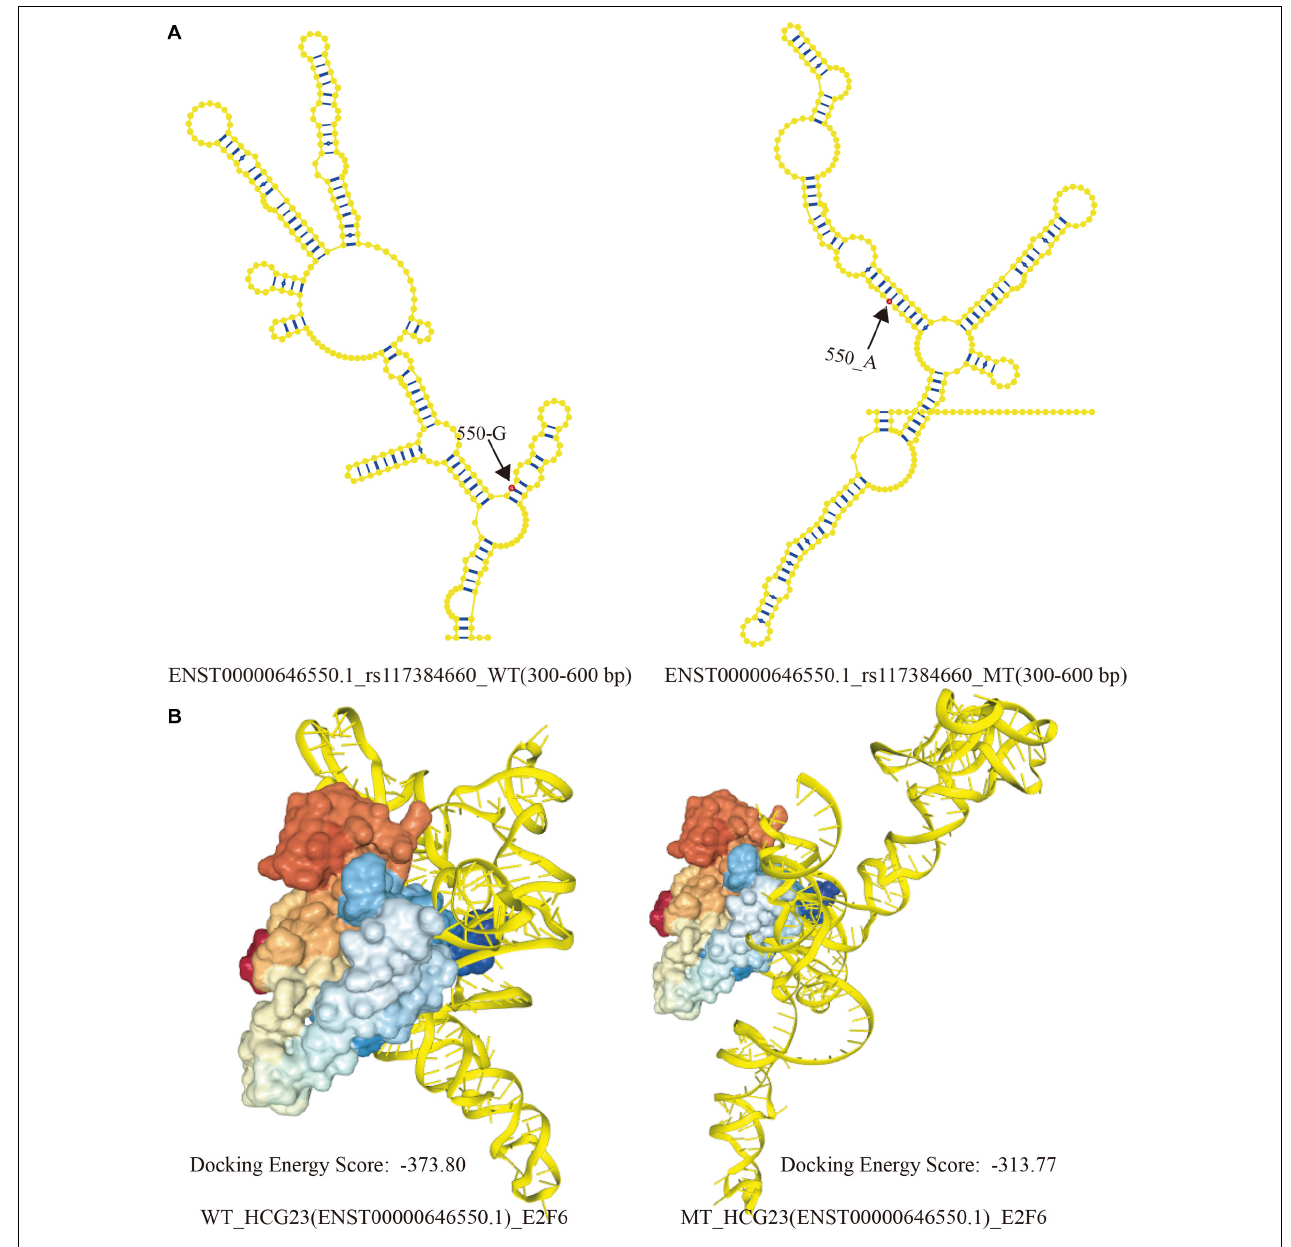
FIGURE 5 | Local structural visualization and prediction of molecular binding. (A) The local secondary structures of WT and MT HCG23 (ENST00000646550.1) induced by rs117384660. Bases in red showed the SNP sites in lncRNA transcript, and the numbers indicated location of SNPs. (B) Predictions of the structural conformations in interactive regions between WT and MT HCG23 and E2F6 induced by LD SNPs using HDOCK (HDOCK: